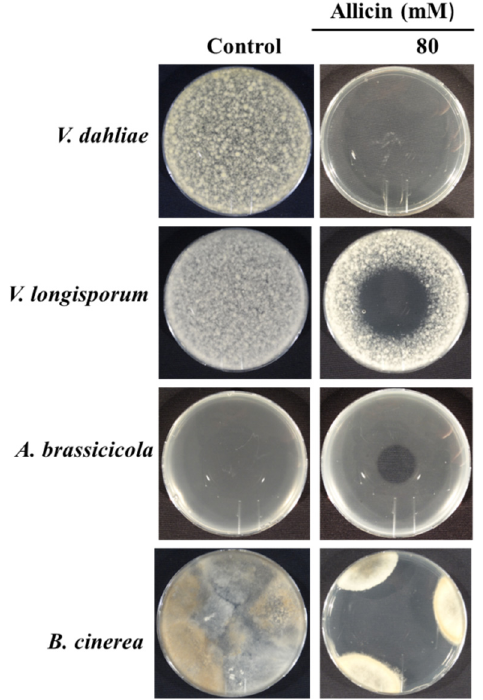
Figure 4. Allicin shows antifungal activity via the gas phase. A 20 μ L drop of an 80 mM solution of allicin was placed at the lid of a Petri dish and covered by the base with bacteria-seeded agar inverted over it. Thus, the agar did not come into contact with the droplet. Inhibition of growth was visible as an inhibition zone with reduced fungal growth. Control plates without allicin exhibit complete fungal growth. However, allicin-containing plates show growth inhibition.